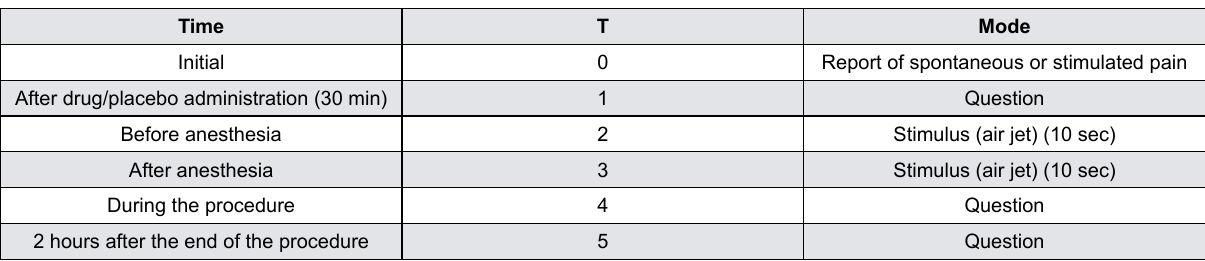
Figure 1- Evaluation times of dental hypersensitivity